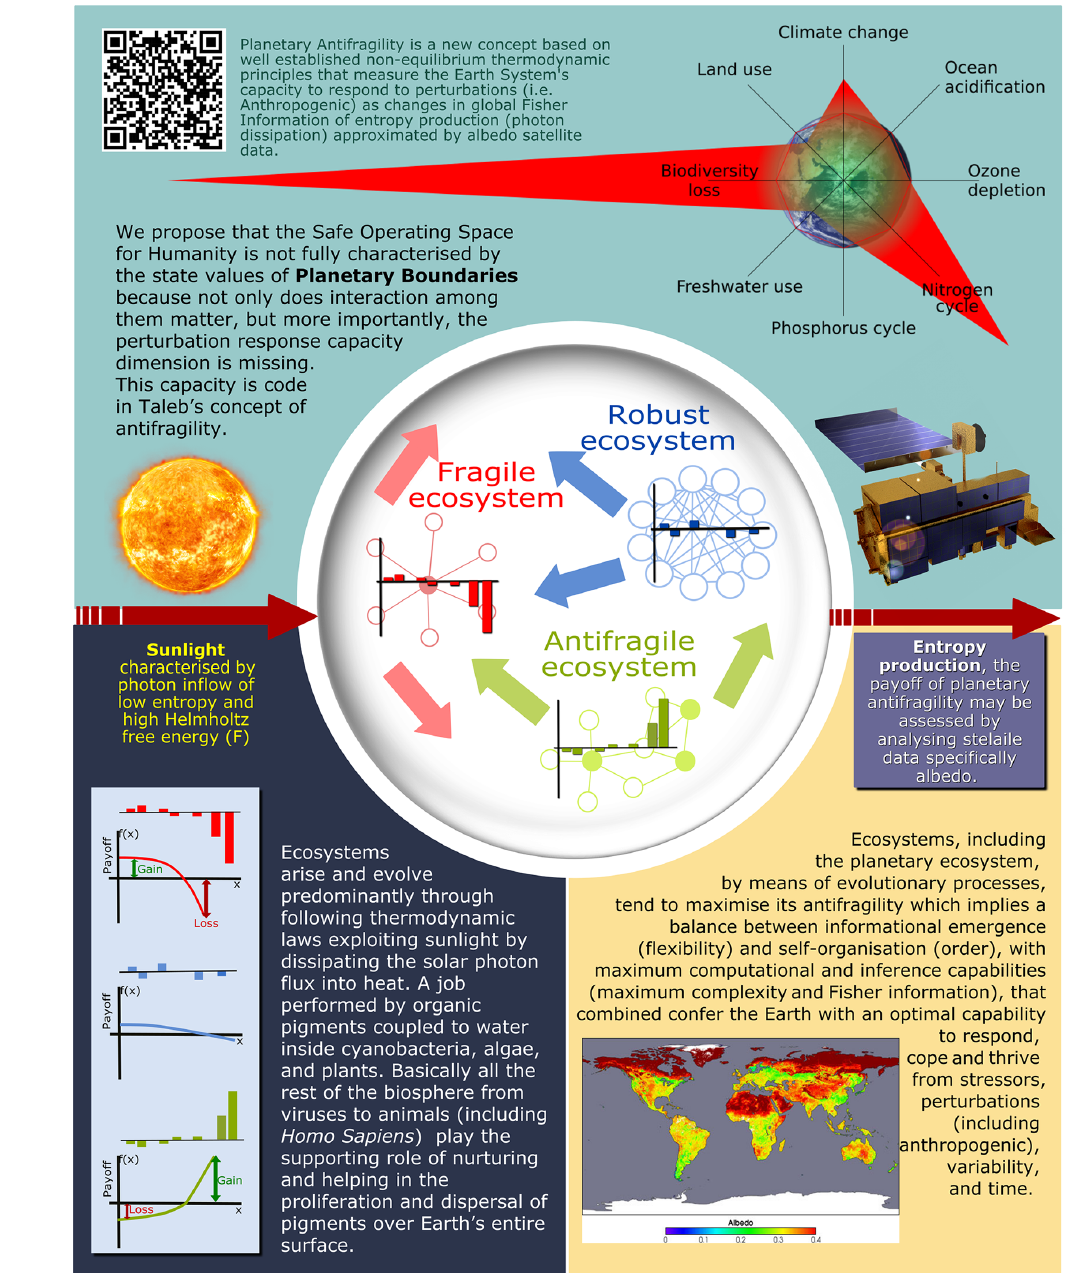
Figure 3. Original figure for the article. Planetary antifragility is a new concept based on well-established non-equilibrium thermodynamic principles that measure the Earth system’s capacity to respond to perturbations (i.e. anthropogenic) as changes in global Fisher information of entropy production (photon dissipation) approximated by albedo satellite